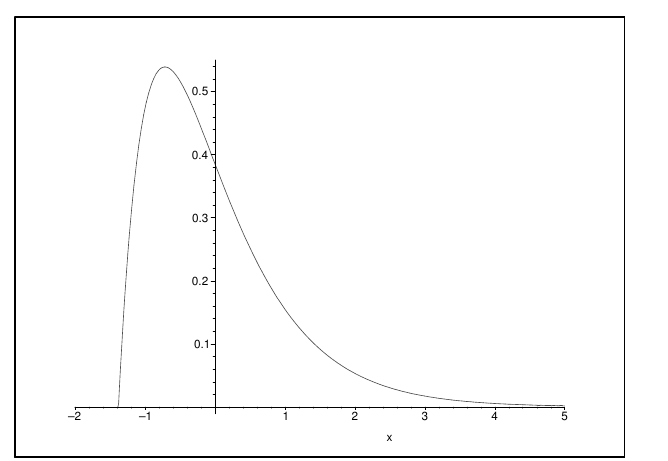
Figure 3 – The graph of pdf f